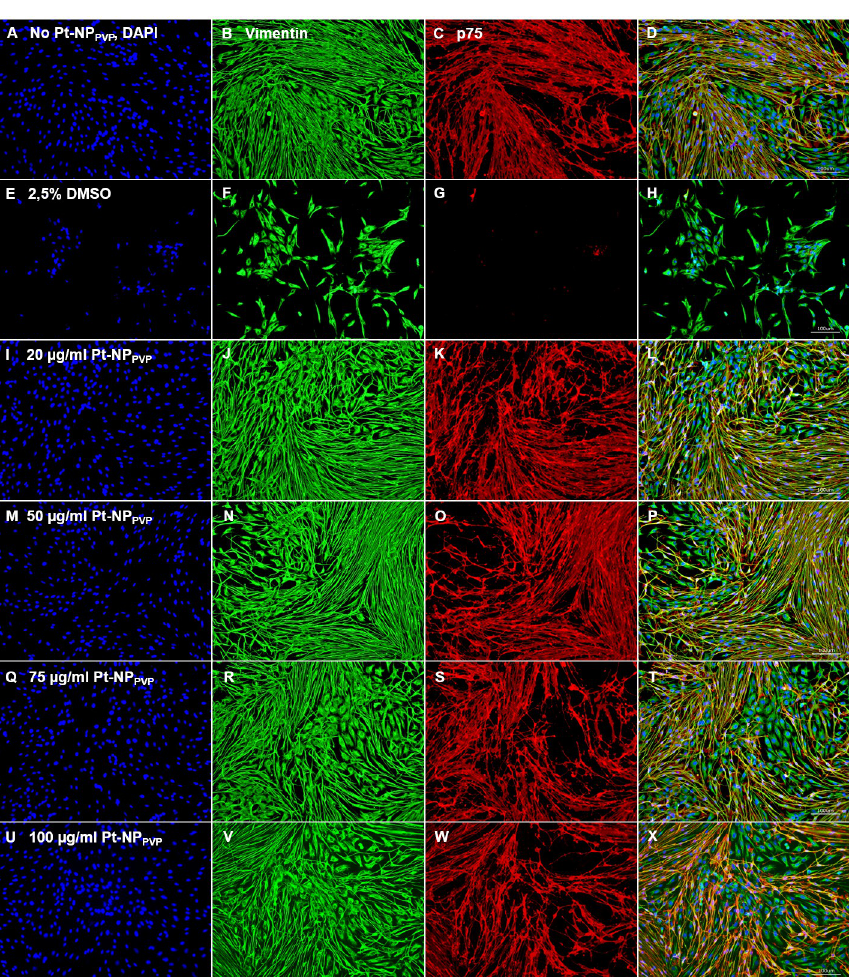
Fig 7. Representative fluorescence images of immunostained SG cells following Pt-NP PVP application for 48 h. Representative fluorescent microscopic views of non-neuronal cells, especially fibroblasts and glial cells, labelled with anti-vimentin (Vim, green) and anti-p75 neurotrophic growth factor receptor (p75-NGFR, red) antibody, respectively. Nuclei were stained with DAPI. Positive staining against vimentin and p75-NGFR antigens were found in cell culture assays without Pt-NP PVP incubation (A-D) and supplied with 20 μ g/ml (I-L), 50 μ g/ml (M-P), 75 μ g/ml (Q-T) and 100 μ g/ml Pt-NP PVP (U-X). Staining of the fibroblasts and glial cells showed vital cells and no morphological irregularities even at the highest Pt-NP PVP concentration. Cells treated with 2.5% DMSO (E-H) were used as negative control. Size of the bars 100 μ